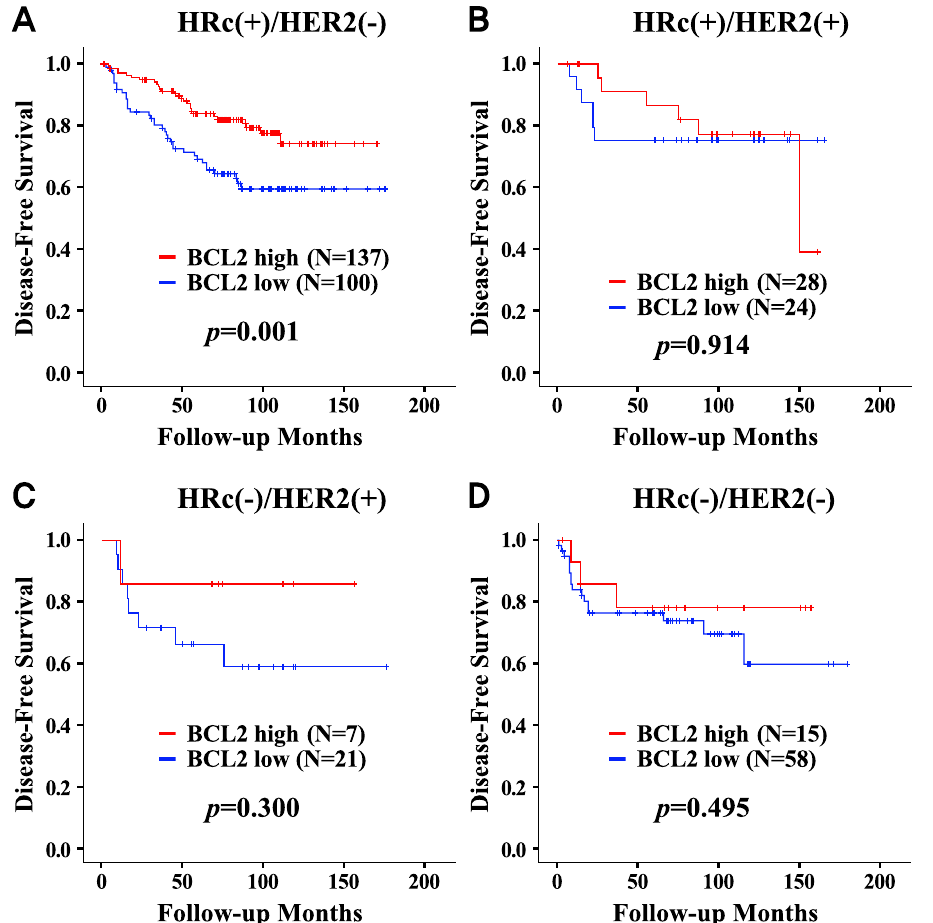
Figure 4. Disease-free survival curve according to BCL2 status in each breast cancer subtype. HRc(+)/HER2(−) ( A ), HRc(+)/HER2(+) ( B ), HRc(−)/HER2(+) ( C ), and HRc(−)/HER2(−) ( D ). Abbreviation: HER2, human epidermal growth factor receptor 2; HRc, hormone receptor; PS, proportion